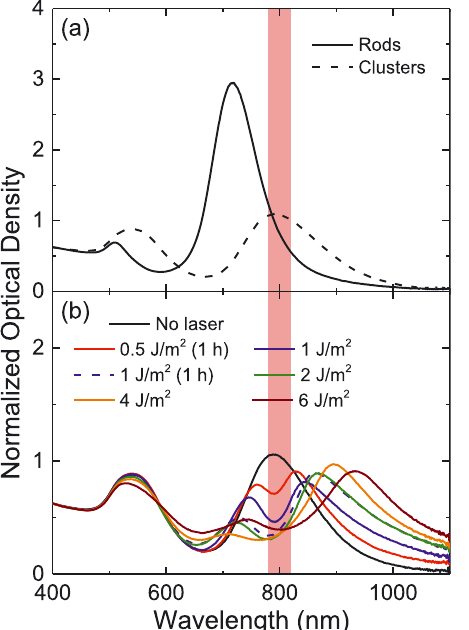
Figure 2: Experimental UV – Vis spectra of (a) bare rods (continuous lines) and rod – sphere clusters (dashed lines) and (b) rod – sphere clusters, before and after irradiation at the fl uences indicated in the graph. Unless indicated otherwise, irradiation was performed for 12 min. The red vertical band represents the spectral extent of the 50 fs laser pulses.